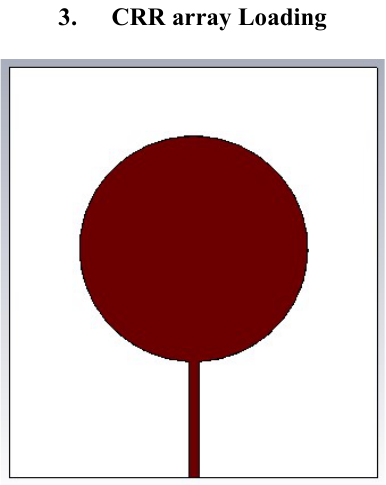
Figure 21: Patch without CRR.